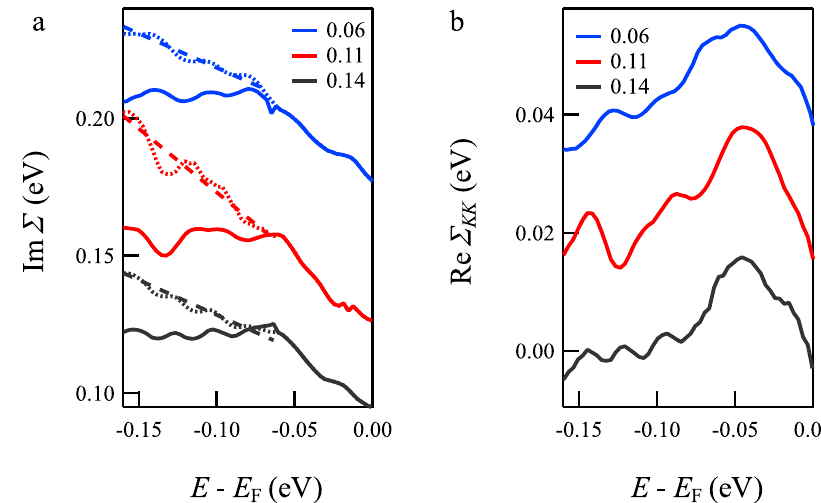
Fig. 3 Imaginary part of self-energy. a Imaginary parts of self-energies (Im Σ ) of the antinodal data in Figs. 1 and 2 for n ~ 0.06 (underdoped), 0.11 (optimally doped), and 0.14 (overdoped) are presented in dotted lines. The solid lines represent the boson contribution to Im Σ after a linear background (dashed lines) is subtracted. b Re Σ KK as the Kramers-Kronig transformation of the boson contribution to Im Σ in a . For both panels, data are shifted vertically for ease of